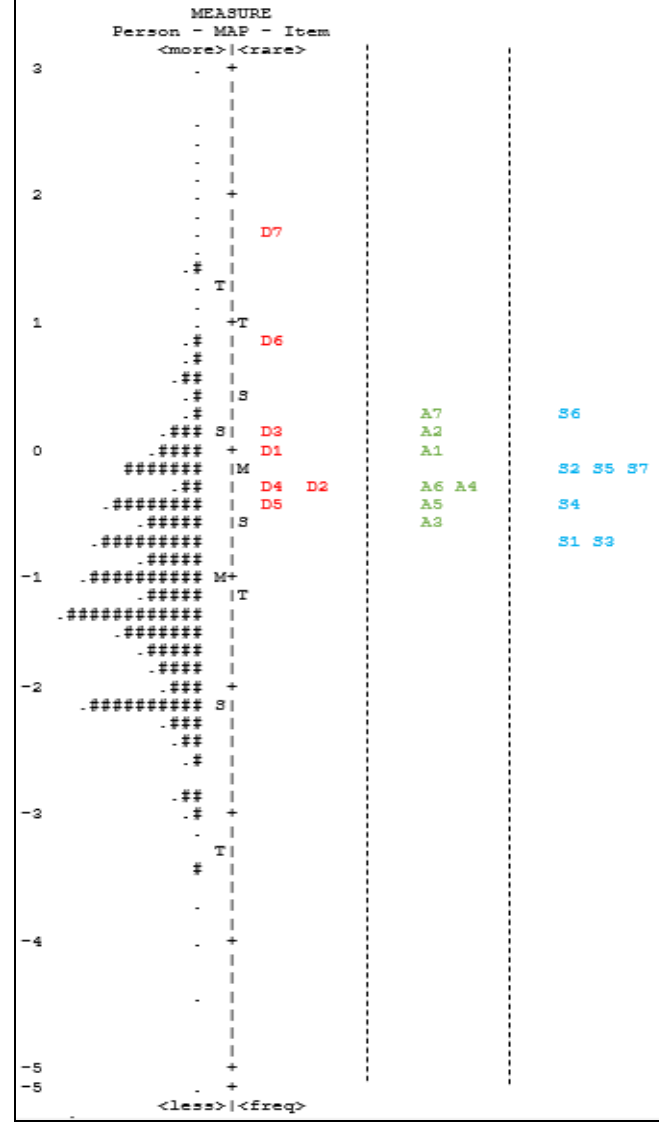
Figure 1. Variable Map (1478 People and 21